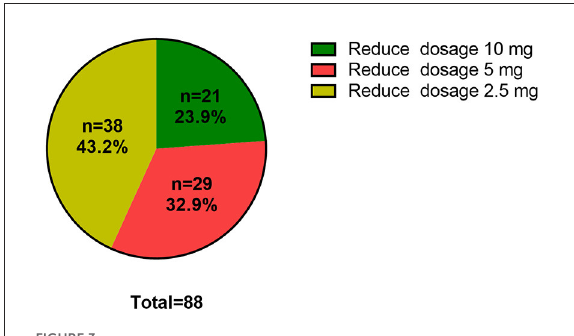
FIGURE3 Proportion of relapse in dosage reduction. Reduced dosage 10 mg, MMI (30–20–10 mg/d); Reduced dosage 5 mg, MMI (10–5 mg/d); Reduced dosage 2.5 mg, MMI (5–2.5 mg/d-withdrawal).